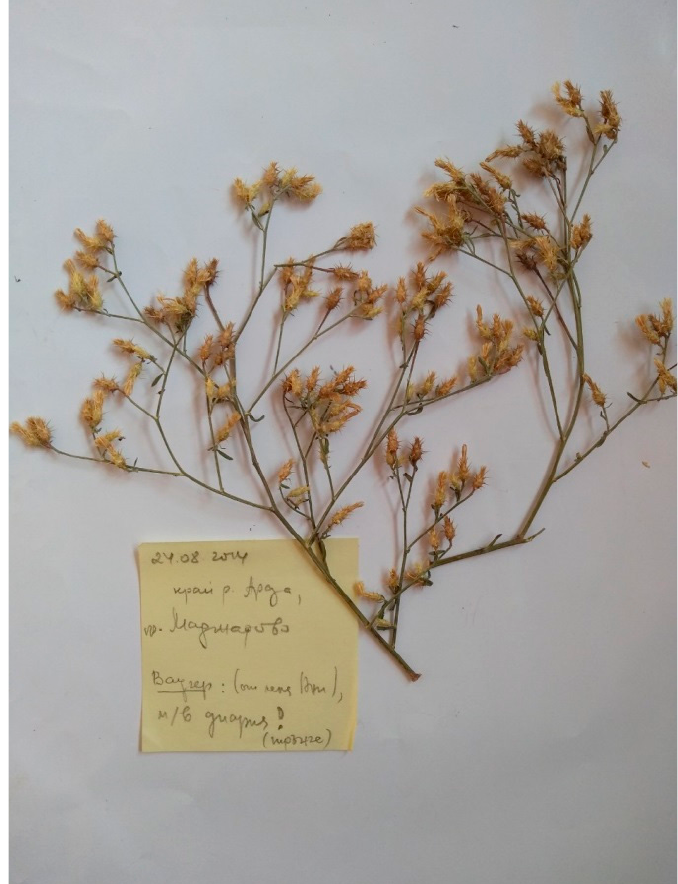
Figure 12. Centaurea diffusa Lam., Трънче .